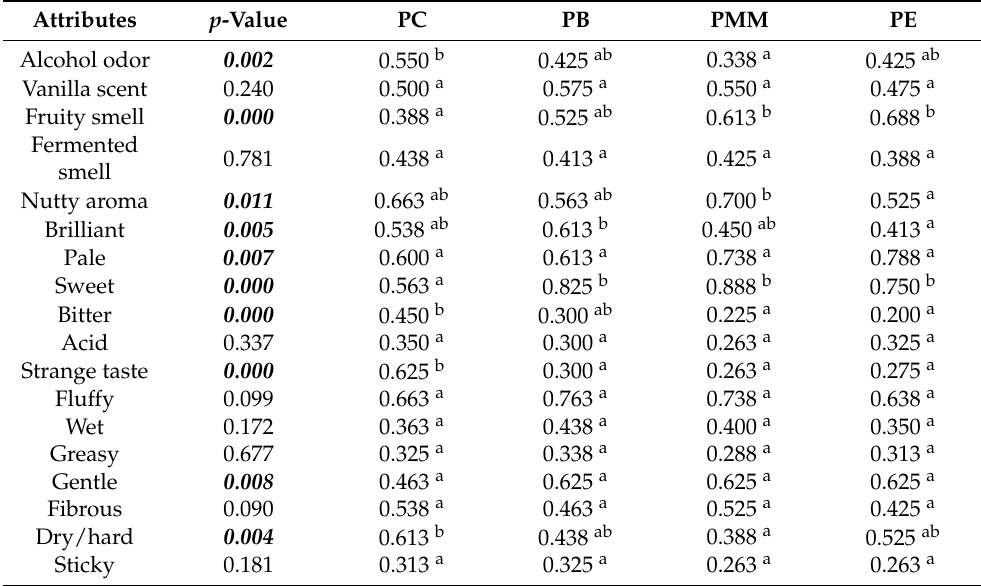
Table 4. Sensory analysis results from Cochran’s Q test after using the CATA